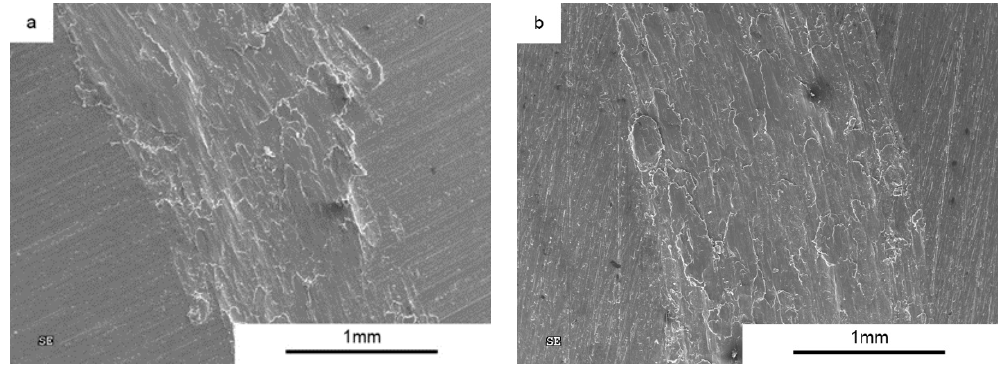
Figure 13. Worn Surface morphology for AA6061 load 1N ( a ) SPS and ( b ) SPT.